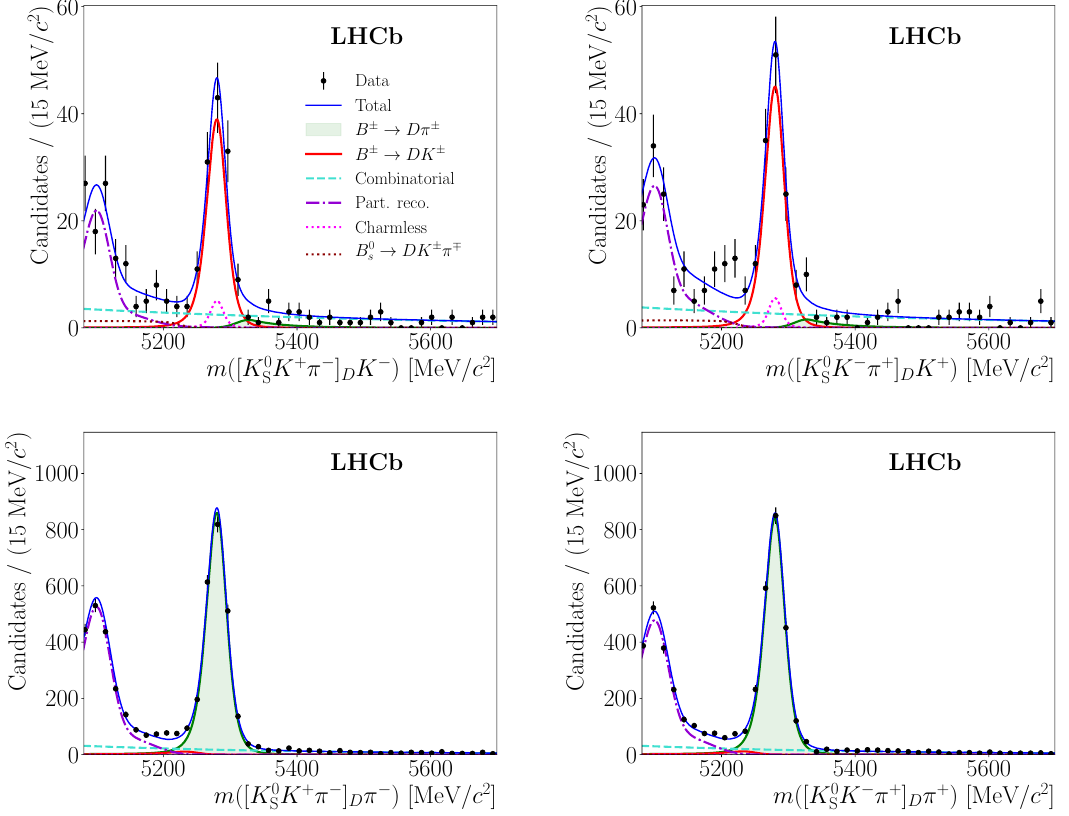
[ K 0 K (cid:7) (cid:25) (cid:6) ] D h (cid:6) candidates in the non- K (cid:3) + region. The (cid:12)t S !